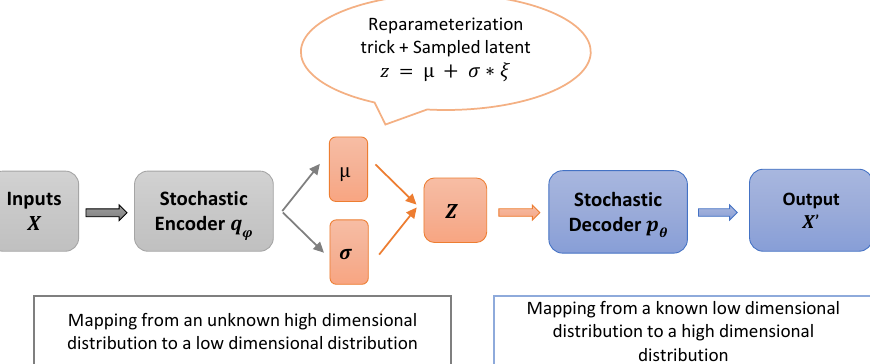
Figure 2. The structure of the variational auto-encoder (VAE). The stochastic encoder q φ ( z | x i ) , also called the inference model, learns stochastic mappings between an observed X -space (input data) and a latent Z -space (hidden representation). The generative model p θ ( z | x i ) , a stochastic decoder, reconstructs the data given the hidden representation.